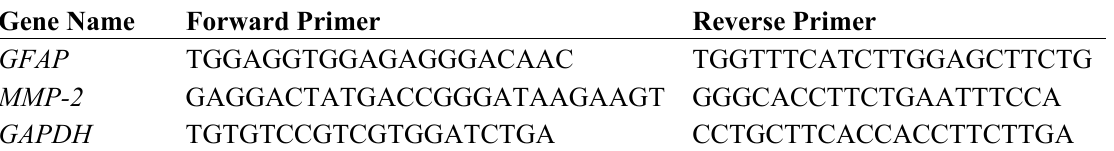
Table 1. Primers used for quantitative polymerase chain